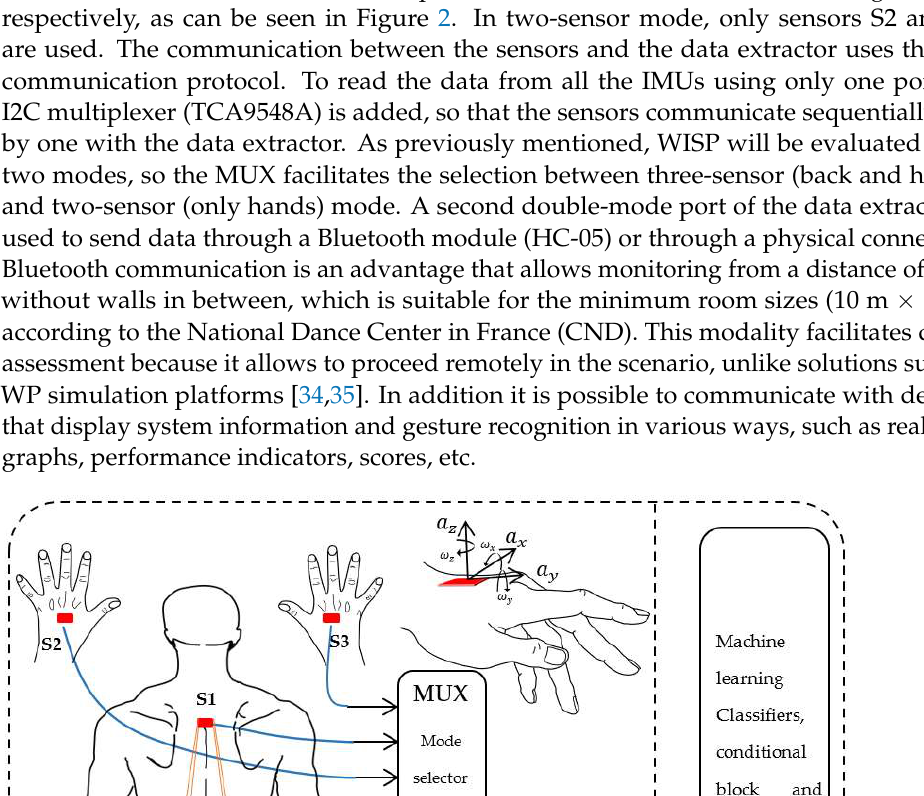
Figure 2. WISP: The left side shows the IMUs placements, the MUX for mode switching, and the data extractor used to extract the raw data. All components on the left side are contained in the wearable part of the system. The right side shows that the wearable part of the system is linked to a processing hardware that uses a classifier to recognize the gestures.